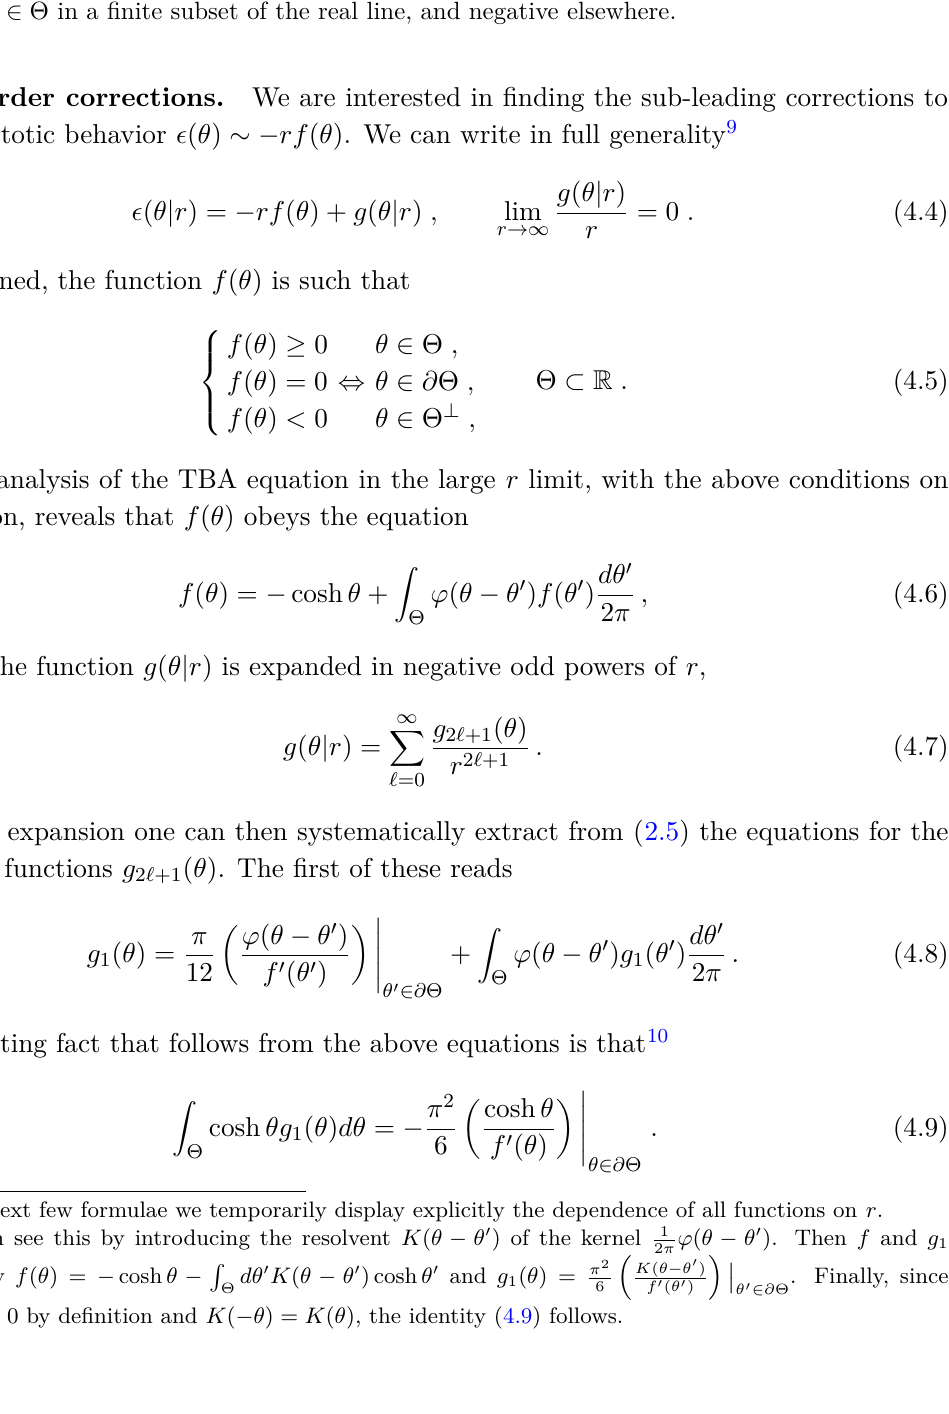
Table 1. Large radius behaviour of the pseudo-energy, L -function and effective central charge in the second branch of real solutions, to first order in r . The function f ( θ ) is non-negative for rapidities θ ∈ Θ in a finite subset of the real line, and negative